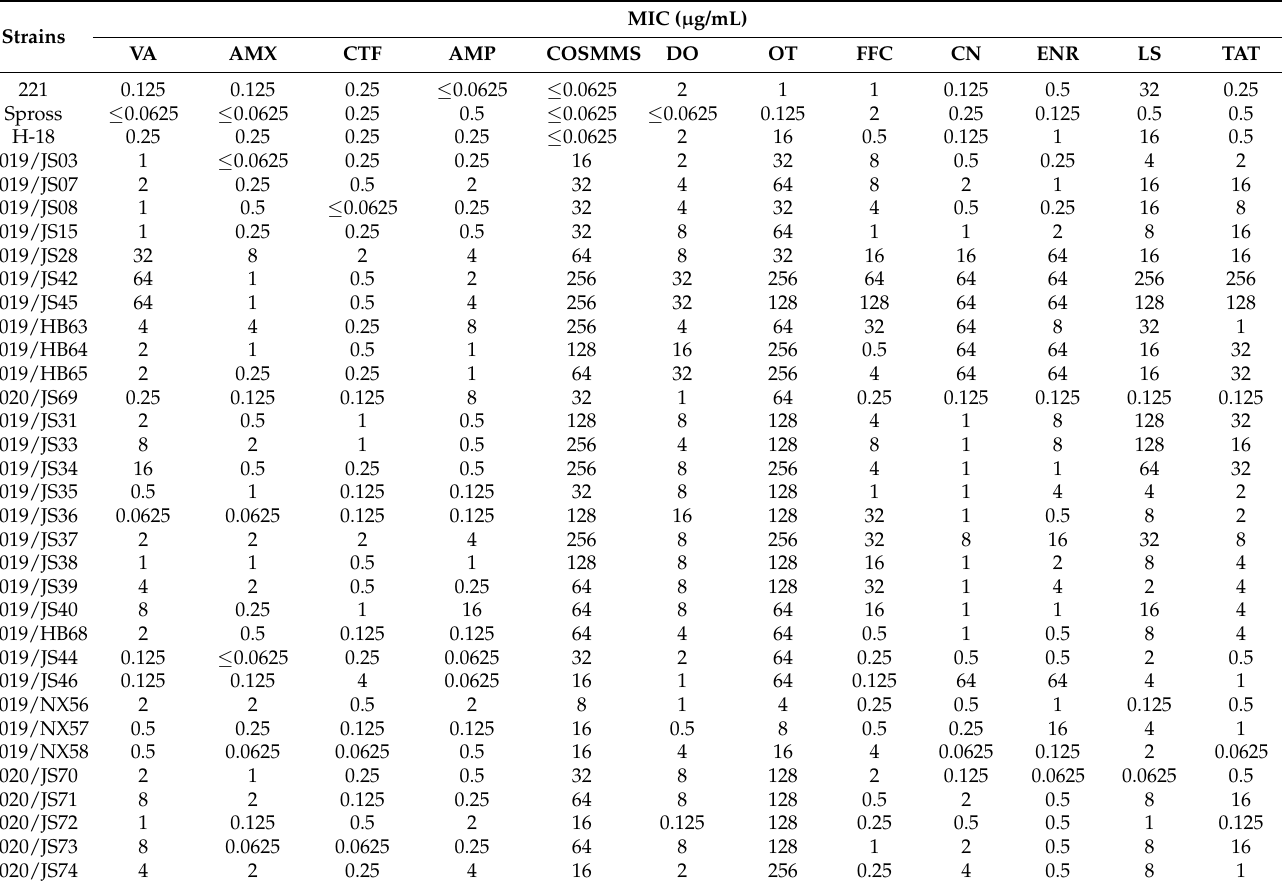
Table 2. Minimum inhibitory concentration of A. paragallinarum